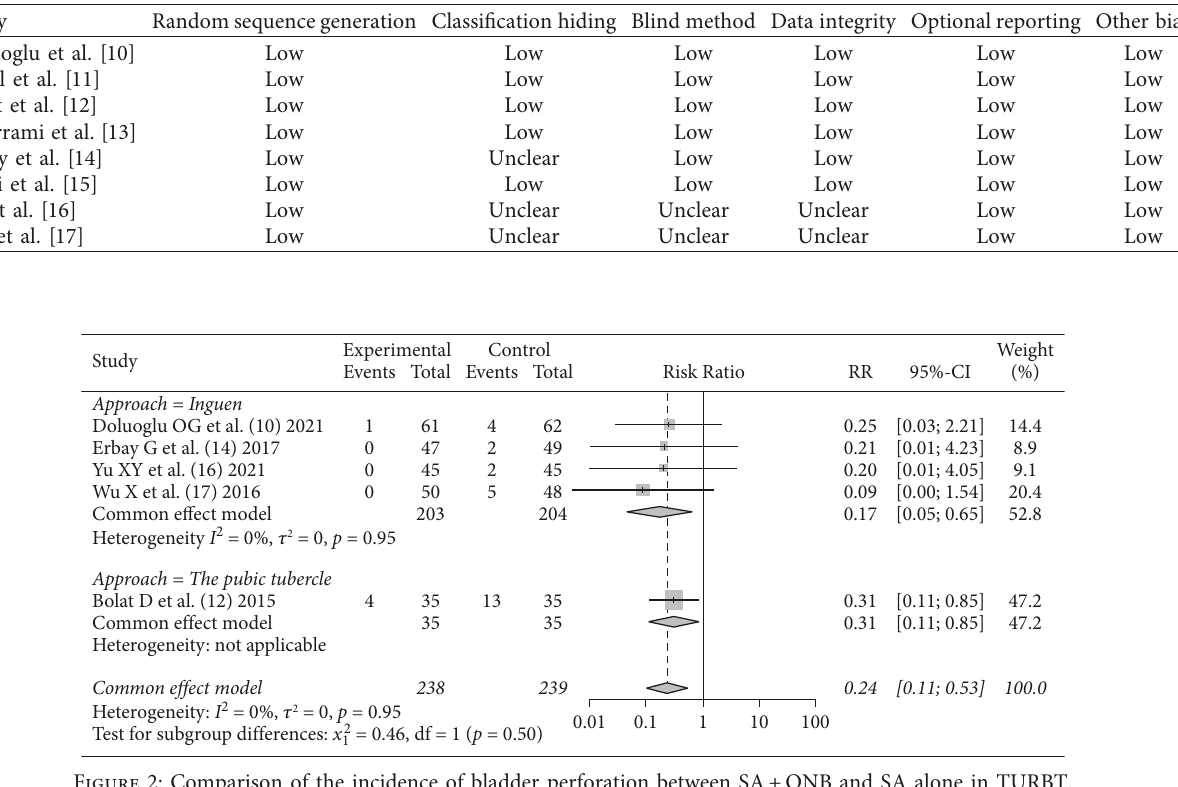
Table 2: Risk of bias based on the cochrane handbook for evaluation of randomized interventions.